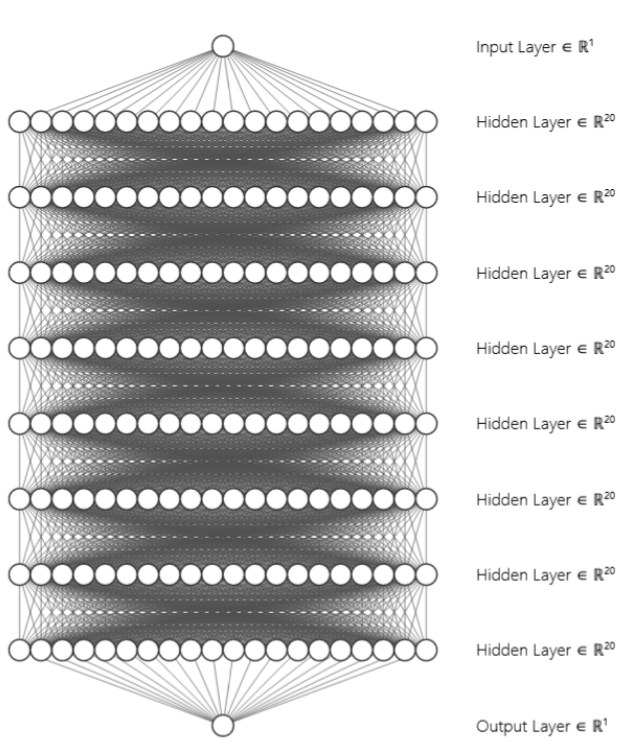
Figure 2. SDNN architecture visualized. A 10-layer network, with hidden layers consisting of 20 neurons each. The leaky ReLU activation function is used on every layer. The total number of learnable parameters is